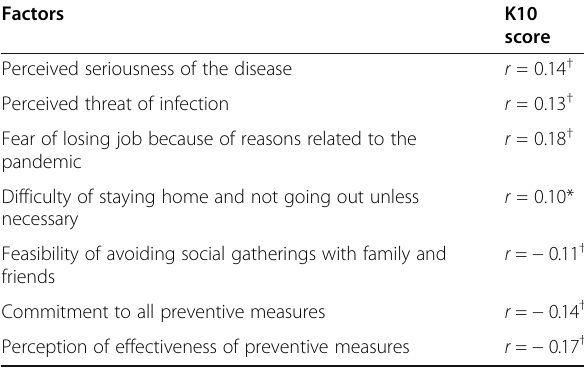
Table 3 Correlation between K10 score of psychological distress and factors related to COVID-19 pandemic among the population living in KSA